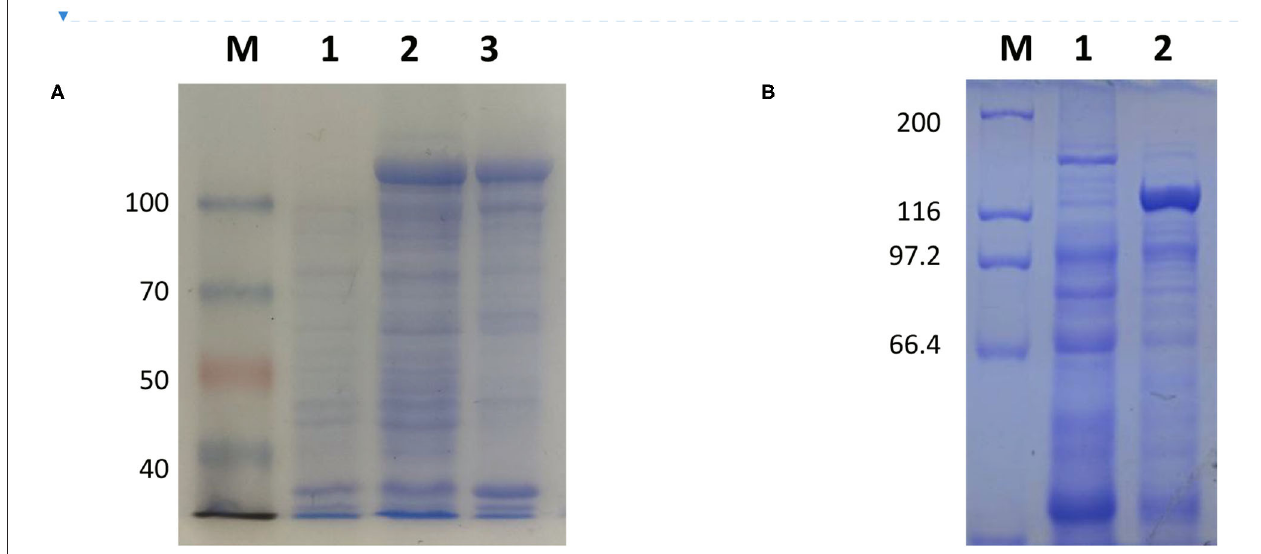
FIGURE 3 | Coomassie blue staining of LwCas13a protein. (A,B) Inducible expression of LwCas13a protein at 18 ◦ C using 500 uM IPTG. Supernatant of lysed cells was analyzed by SDS-PAGE and stained by Coomassie blue. (A) M: 100 kDa Priten marker; 1: Uninduced sample 2: Induce sample supernatant, 3: Induced sample of precipitation Purified. (B) M: 200 kDa Priten marker; 1:Uninduced sample, 2: purification of LwaCas13a protein.